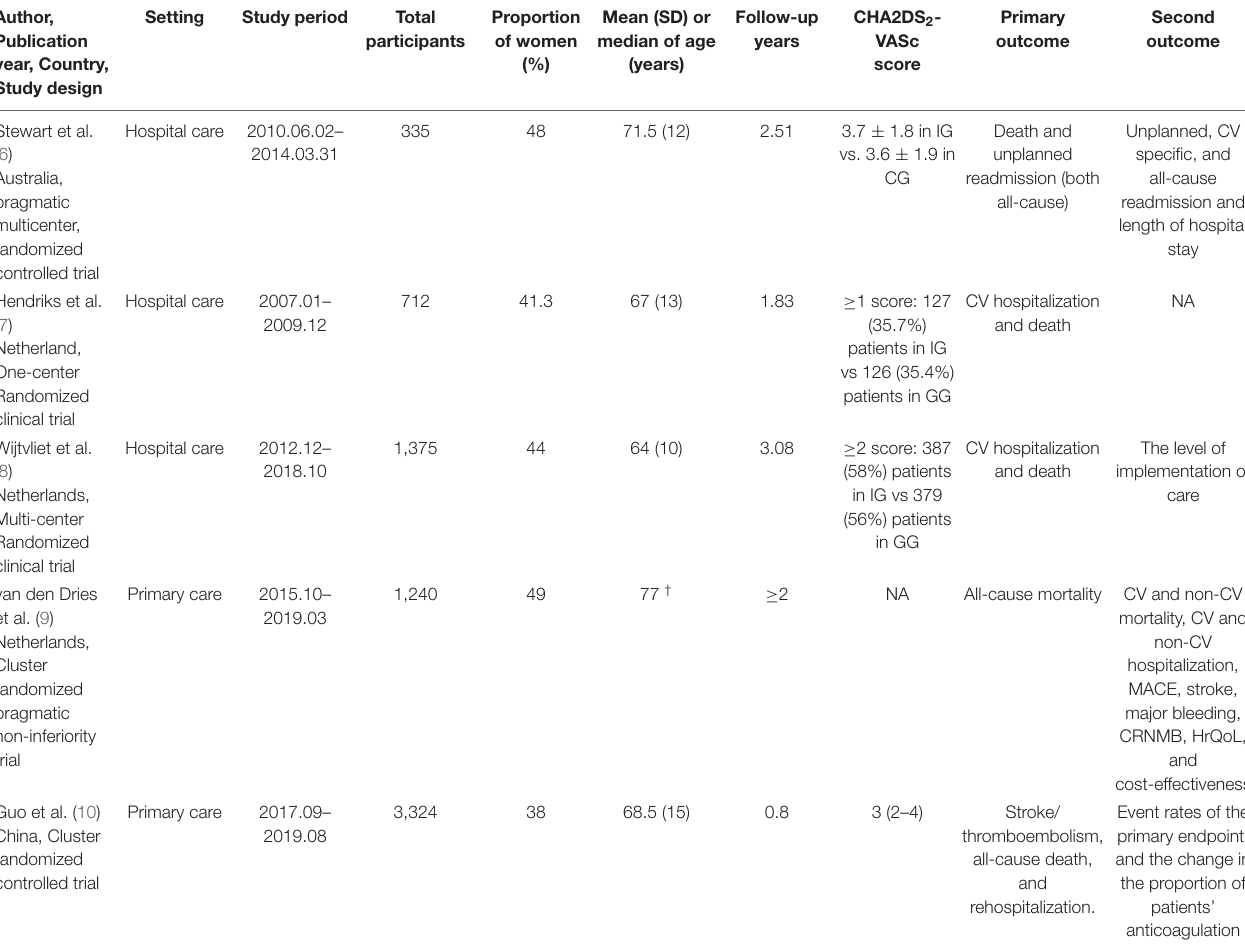
TABLE 1 | Characteristics of included